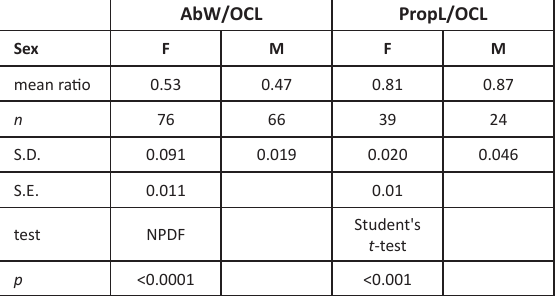
Table 3. Sexual dimorphism for E. sulcatus animals (>50 mm OCL) from the long-term monitoring site at Brindle Creek: i) relative abdomen width (AbW/OCL); and ii) relative propodal length (PropL/ OCL). F = female; M = male; NPDF = normal probability density